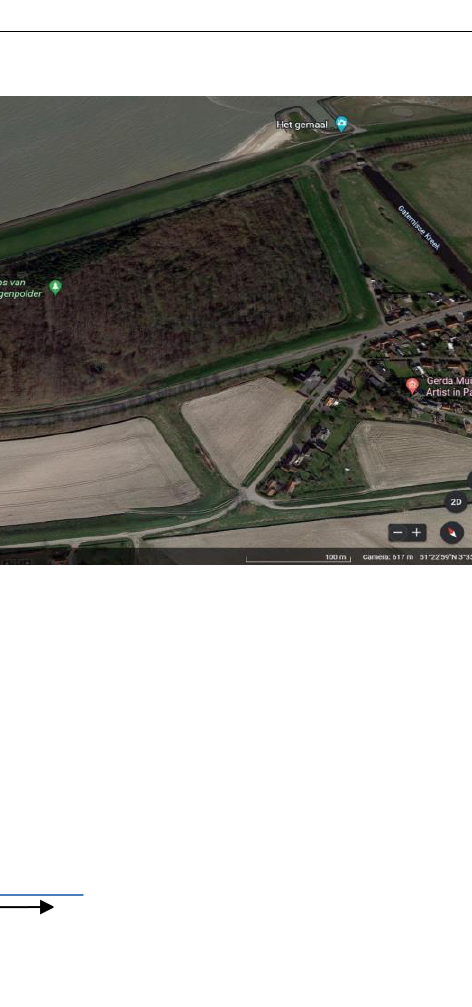
Figure 3. Coverage Concept Scenario.